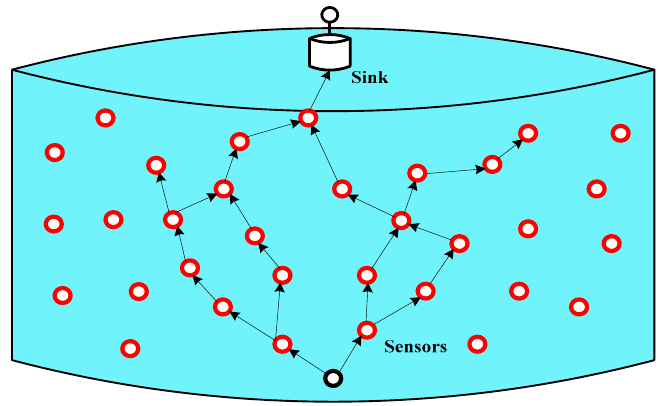
Figure 4. Deployment of PER in USWNs.